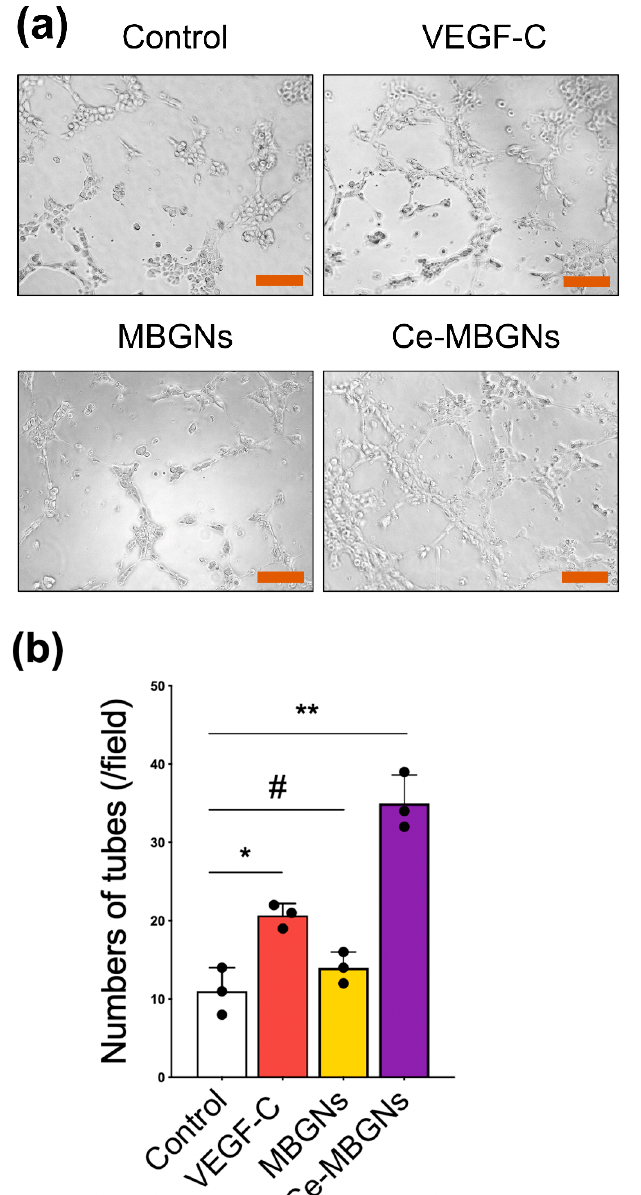
Figure 6. Tube-formation assessed using the Matrigel assay. The results were recorded after 3 h. ( a ) Tube formation of LECs cultured with conditioned media VEGF-C (50 ng/mL), MBGNs (1 wt/v% extract), and Ce-MBGNs (1 wt/v% extract) and the control. Scale bar = 100 μ m. ( b ) LEC tube for- mation was quantified using the images. The experiment was performed at least in triplicate inde- pendently with three technical repeats. p < 0.05 (*), p < 0.01 (**) and p > 0.05 (#).